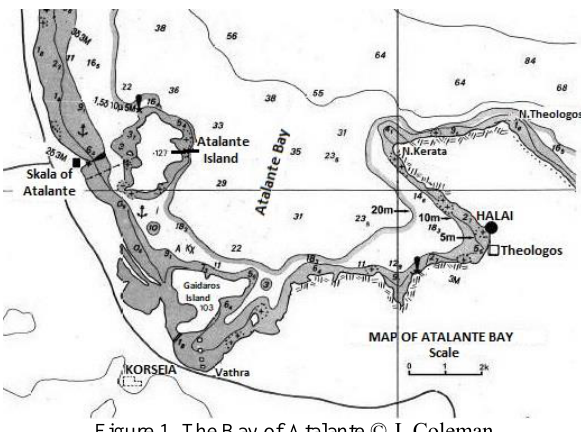
Figure 1. The Bay of Atalante © J. Coleman